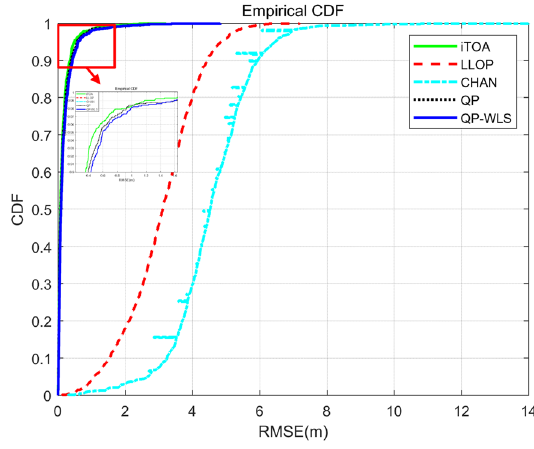
Figure 1: CDF of RMSE with NLOS error of 2 m and time synchroni - zation error of 3 m.